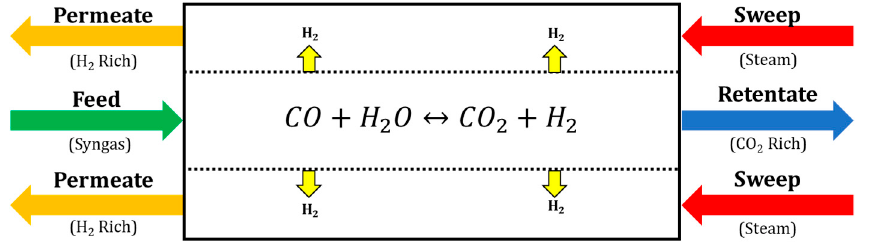
Figure 5. Schematic of a shell and tube WGS-MR for hydrogen recovery and carbon capture. Table 1. Component permeance ( Q i,o ) values used reported in gas permeation units (GPU). Component